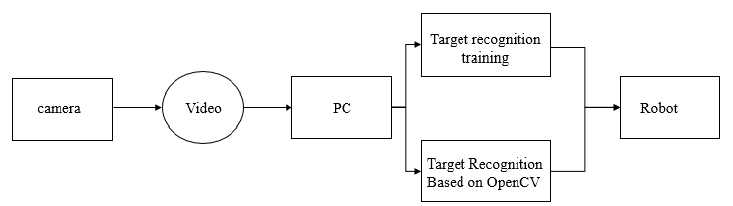
Figure 9. System flow chart.